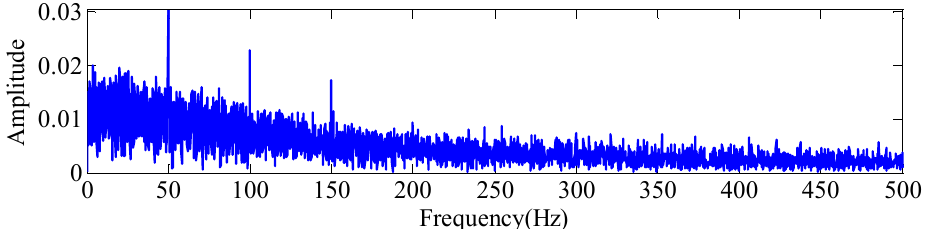
Figure 11. Signal segment with random value at 7 seconds to construct singular value decomposi- tion of Hankel matrix to reduce envelope spectrum of noise signal.